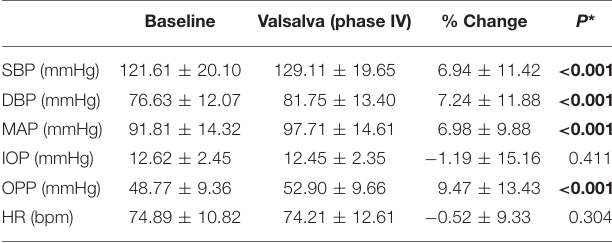
TABLE 1 | Blood pressure, heart rate, intraocular pressure, and ocular perfusion pressure at baseline and during Phase IV of the Valsalva maneuver.